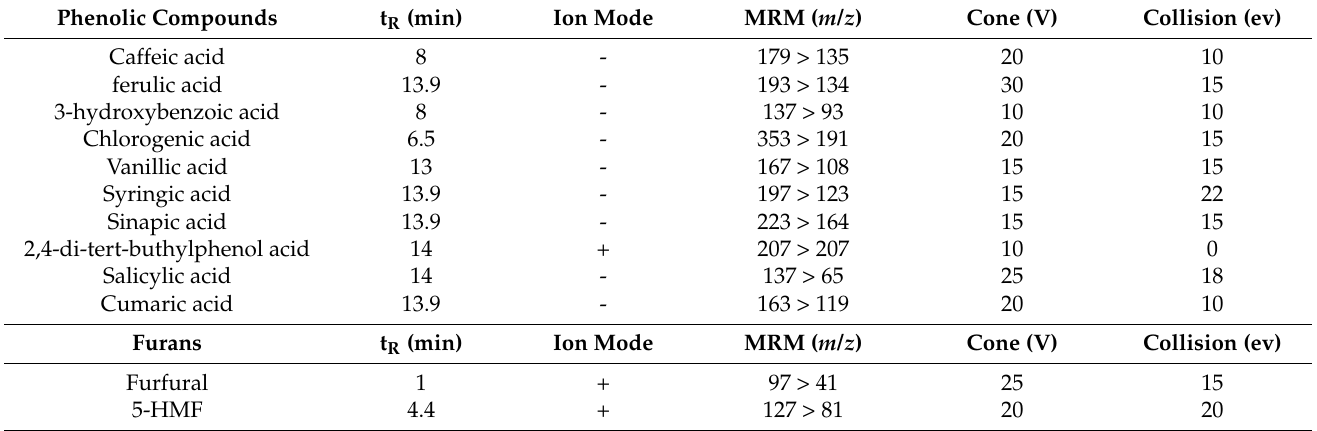
Table 4. Mass spectrometric conditions for furans and phenolic compounds.